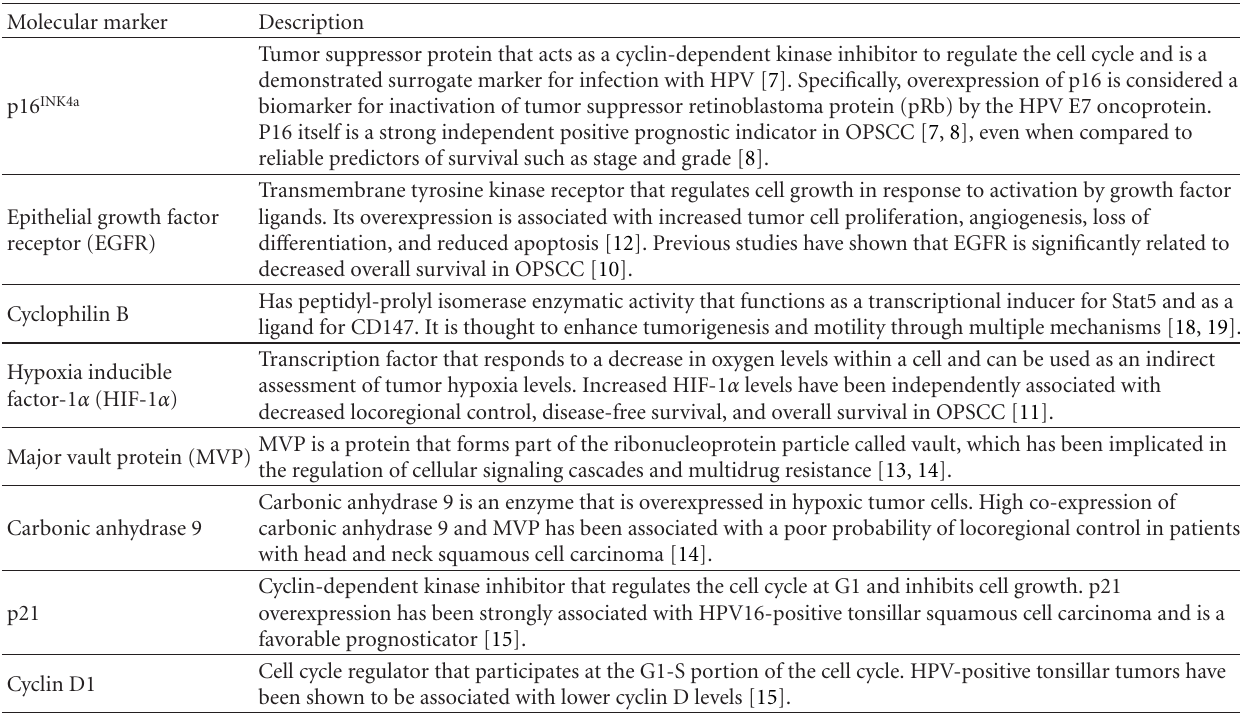
Table 1: Description of